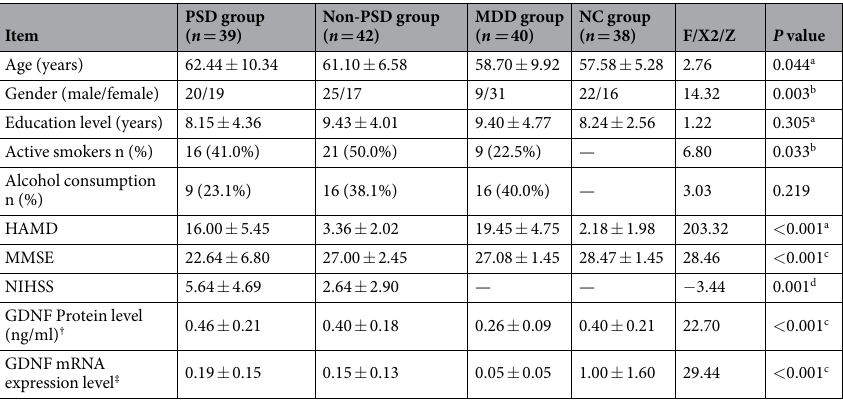
Table 2. Demographic and data, GDNF protein and mRNA expression levels among four groups. Note: Data reported as mean ± SD and ratio. PSD: post stroke depression; Non-PSD: stroke without depression; MDD: major depressive disorder; NC: normal control. HAMD: Hamilton depression rating scale; MMSE: mini mental state examination. NIHSS: National Institutes of Health Stroke Scale. a One-way ANOVA. b Chi square test. c Kruskal-Wallis test. d Mann-Whitney U test. † nine abnormal data were excluded (two PSD patients, two Non-PSD patients, four MDD patients and one NC subject); ‡ five abnormal data were excluded (four Non-PSD patients and one MDD